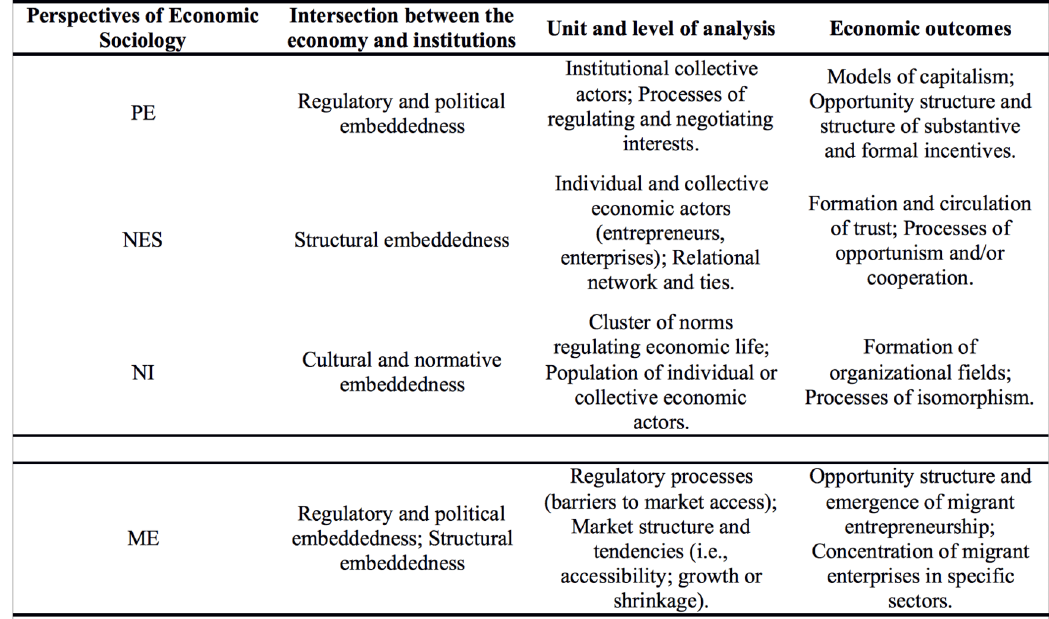
Fig. 1: Mixed Embeddedness (ME) in the Light of the Main Perspectives of Economic